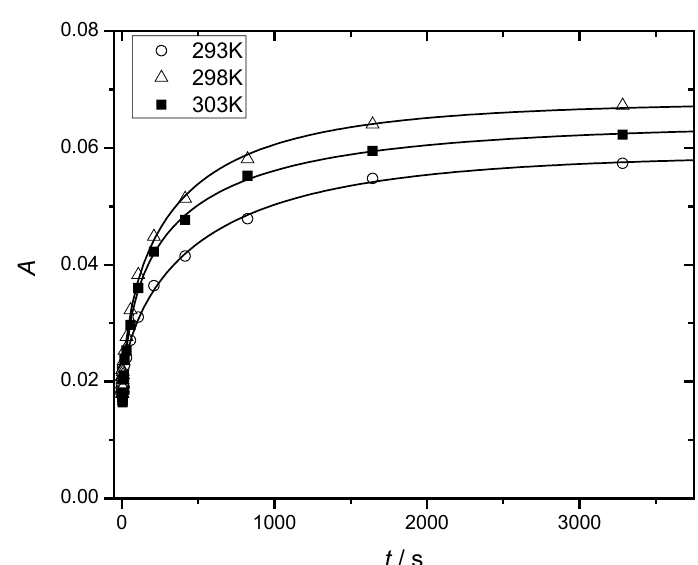
Figure 6. Kinetic data fits obtained using stretched exponential